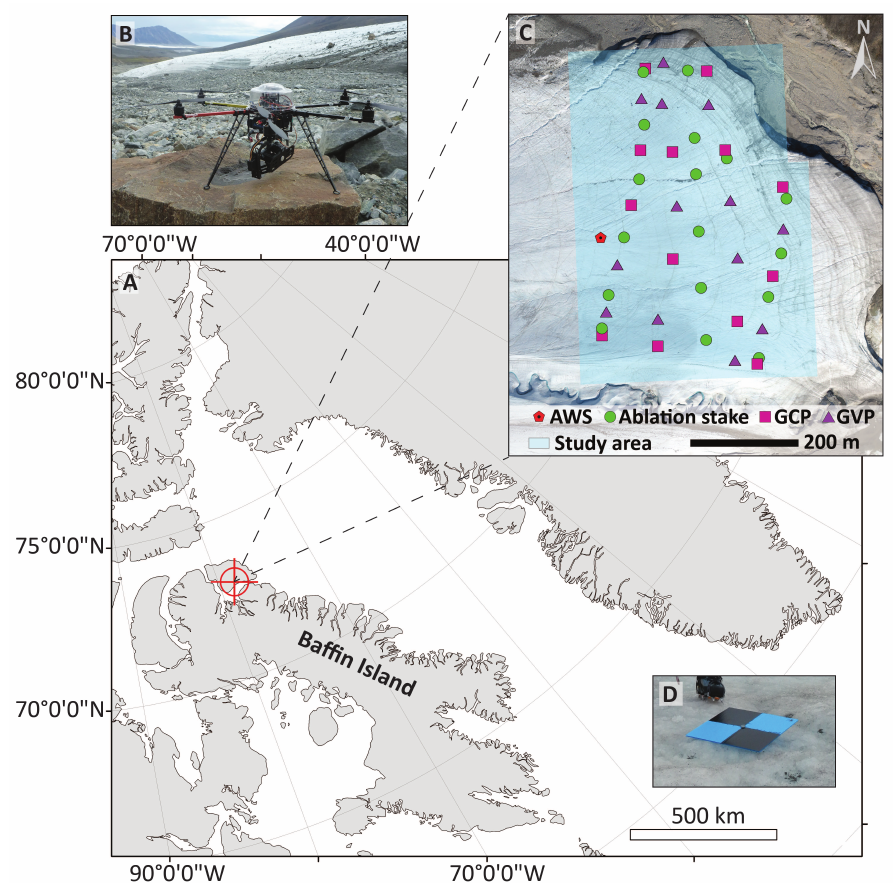
Figure 1. ( A ) Fountain Glacier is located in the Canadian Arctic on Bylot Island, NU (72.96 ◦ N, 78.42 ◦ W). The glacier is approximately 1 km wide and 16 km long, with an average temperature recorded in the ablation area of − 11.6 ◦ C in 2015–2016. ( B ) The UAV used in this study was a six-propellor unit designed by MikroKopter Inc. ( C ) A study area was established in the lower ablation area on Fountain Glacier in July 2016 (blue shading). An AWS was located in the western portion of the area (red triangle), and 17 ablation stakes were installed on 14 July (green circles). A grid of 26 targets were installed on the glacier surface to serve as ground control points (GCPs; pink squares) and ground validation points (GVPs; purple triangles). ( D ) Example of target used for GCPs and